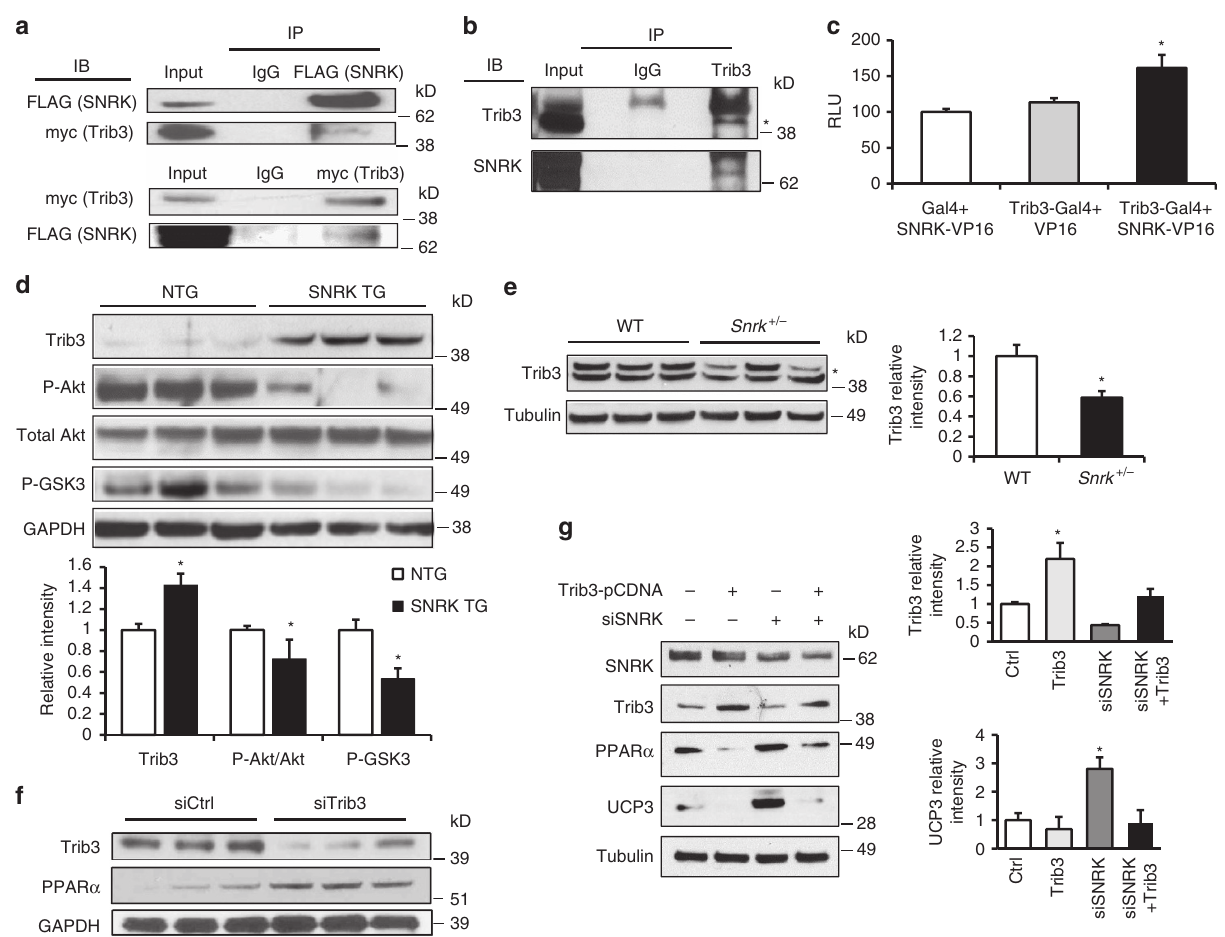
Figure 4 | SNRK decreases PPAR a and UCP3 through upregulation of Trib3. ( a ) Co-immunoprecipitation of FLAG-SNRK and myc-Trib3 in HEK293 cells. IP: immunoprecipitation antibody, IB: immunoblot antibody. ( b ) Co-immunoprecipitation of endogenous SNRK with Trib3 from mouse hearts. Asterisk indicates Trib3 band. ( c ) Mammalian two hybrid assay of SNRK-VP16 and Trib3-GAL4 in HEK293 cells. RLU, relative luminescence units. n ¼ 9. ( d ) Western blots of Trib3, p-S473 Akt, total Akt, p-GSK3 and GAPDH in NTG and SNRK TG hearts. Graphs show summary of n ¼ 8 for Trib3 relative to loading control, n ¼ 8–9 for p-Akt relative to total Akt, and n ¼ 4 for p-GSK3 relative to GAPDH. ( e ) Western blots of Trib3 and tubulin in WTand Snrk þ / (cid:2) hearts. Asterisk denotes nonspecific band. Densitometry shows summary of n ¼ 4–5. ( f ) Western blots of Trib3, PPAR a , and GAPDH in HL1 cells treated with control or Trib3 siRNA. ( g ) Western blots of SNRK, Trib3, PPAR a , UCP3 and tubulin in HL1 cells transfected with pCDNA or Trib3-pCDNA and control or SNRK siRNA. Densitometry shows summary of n ¼ 5. Data are represented as mean ± s.e.m. * P r 0.05 by one-way ANOVA or Student’s t -test. ANOVA, analysis of